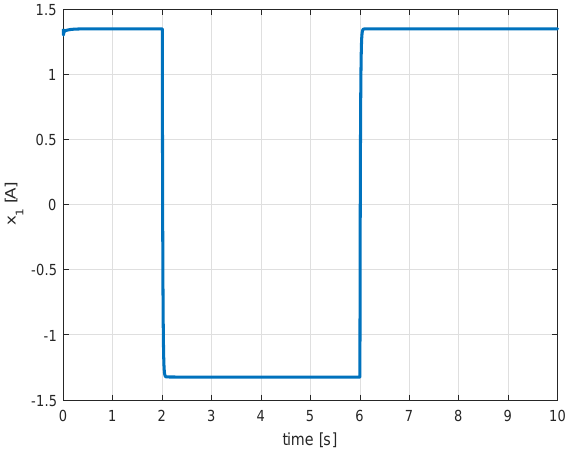
Figure 9. Simulation Case: Inductor